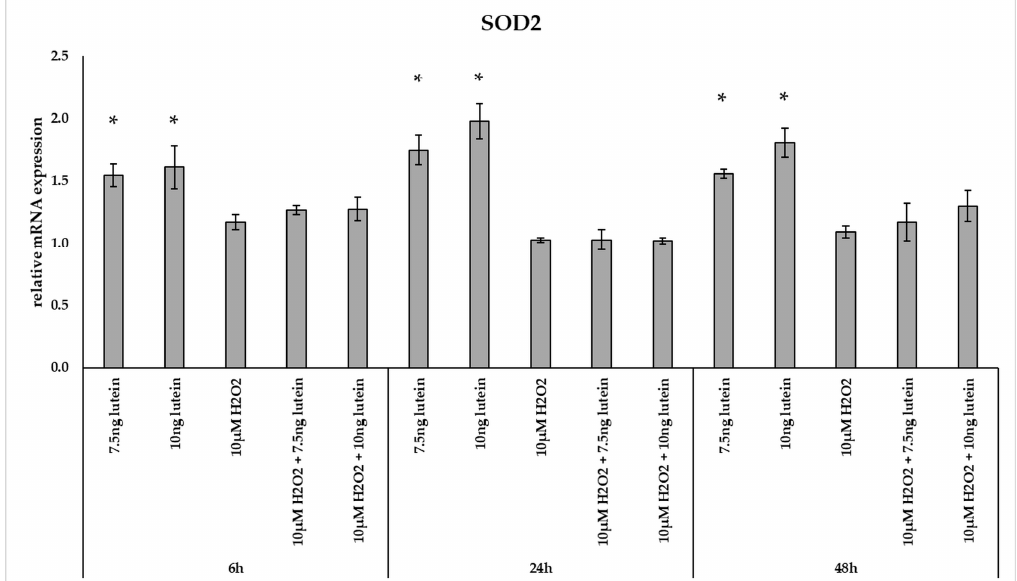
Figure 3. Relative mRNA expression of SOD2 in the lutein and in H 2 O 2 treated BV-2 cells . The columns represent the mean values and error bars indicate the standard deviation (SD) of three independent experiments ( n = 3), each performed in triplicate, and are presented relative to own control cells. * indicates statistical significance of lutein treatments versus controls; the level of significance was p < 0.05. Real-time PCR was performed with the SYBR green protocol using gene- specific primers. β -actin was used as house-keeping gene for the normalization. The relative expression of controls was regarded as 1.